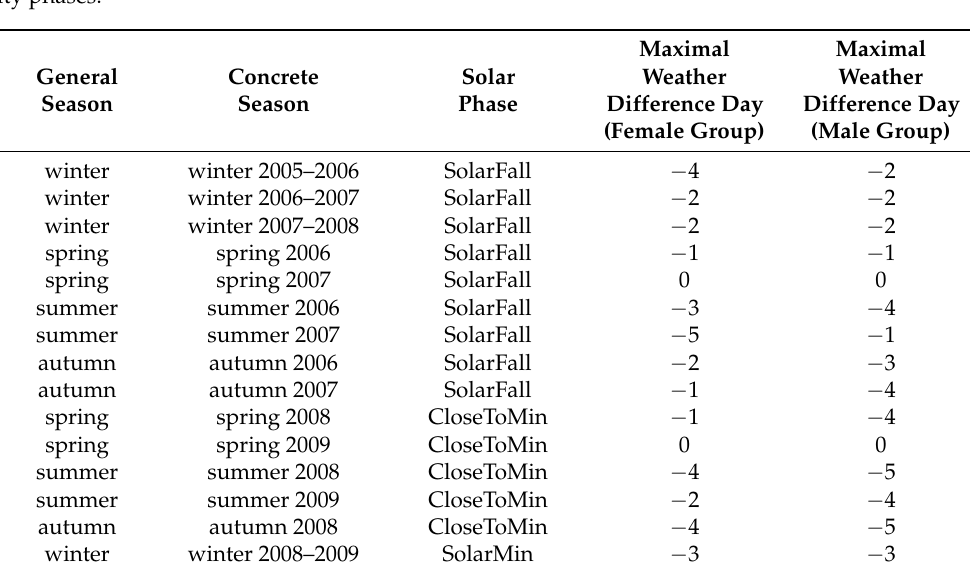
Figure 4. The distribution of Maximal Difference Days when they corresponded to the different medical events in the half-interval of folder epochs. Different gender groups from the medical call logs for the ischemia cases. Table 2. The list of Weather Maximal Difference Days in concrete seasons and concrete solar activ- ity